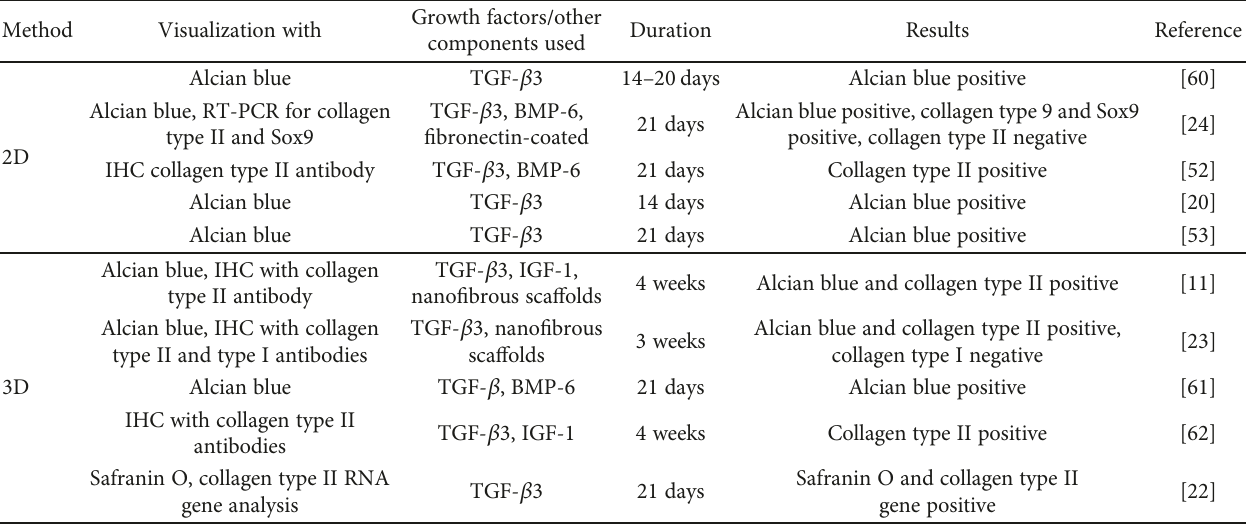
Table 2: Evidence of MenSC chondrogenic di ff